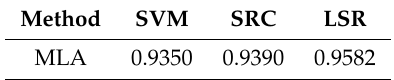
Table 2. The comparison of classification models based on the feature representation model MLA.